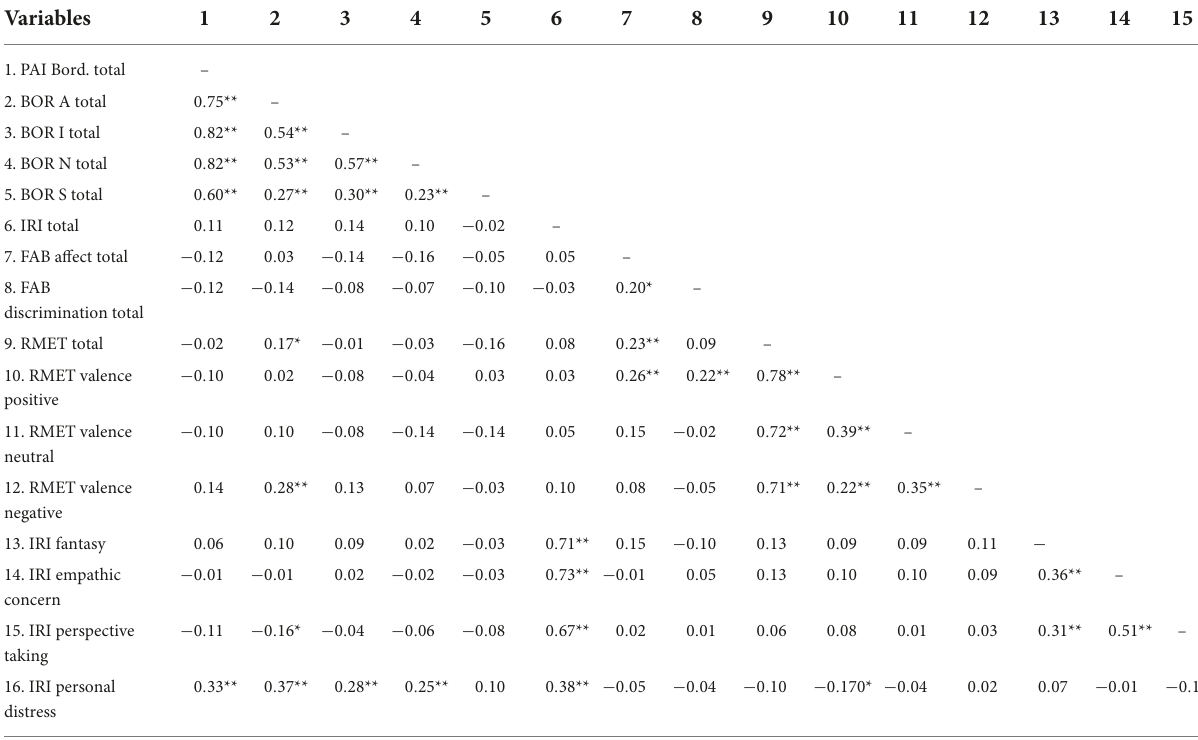
TABLE 1 Pearson’s correlation statistics for BPD trait and social cognition variables.